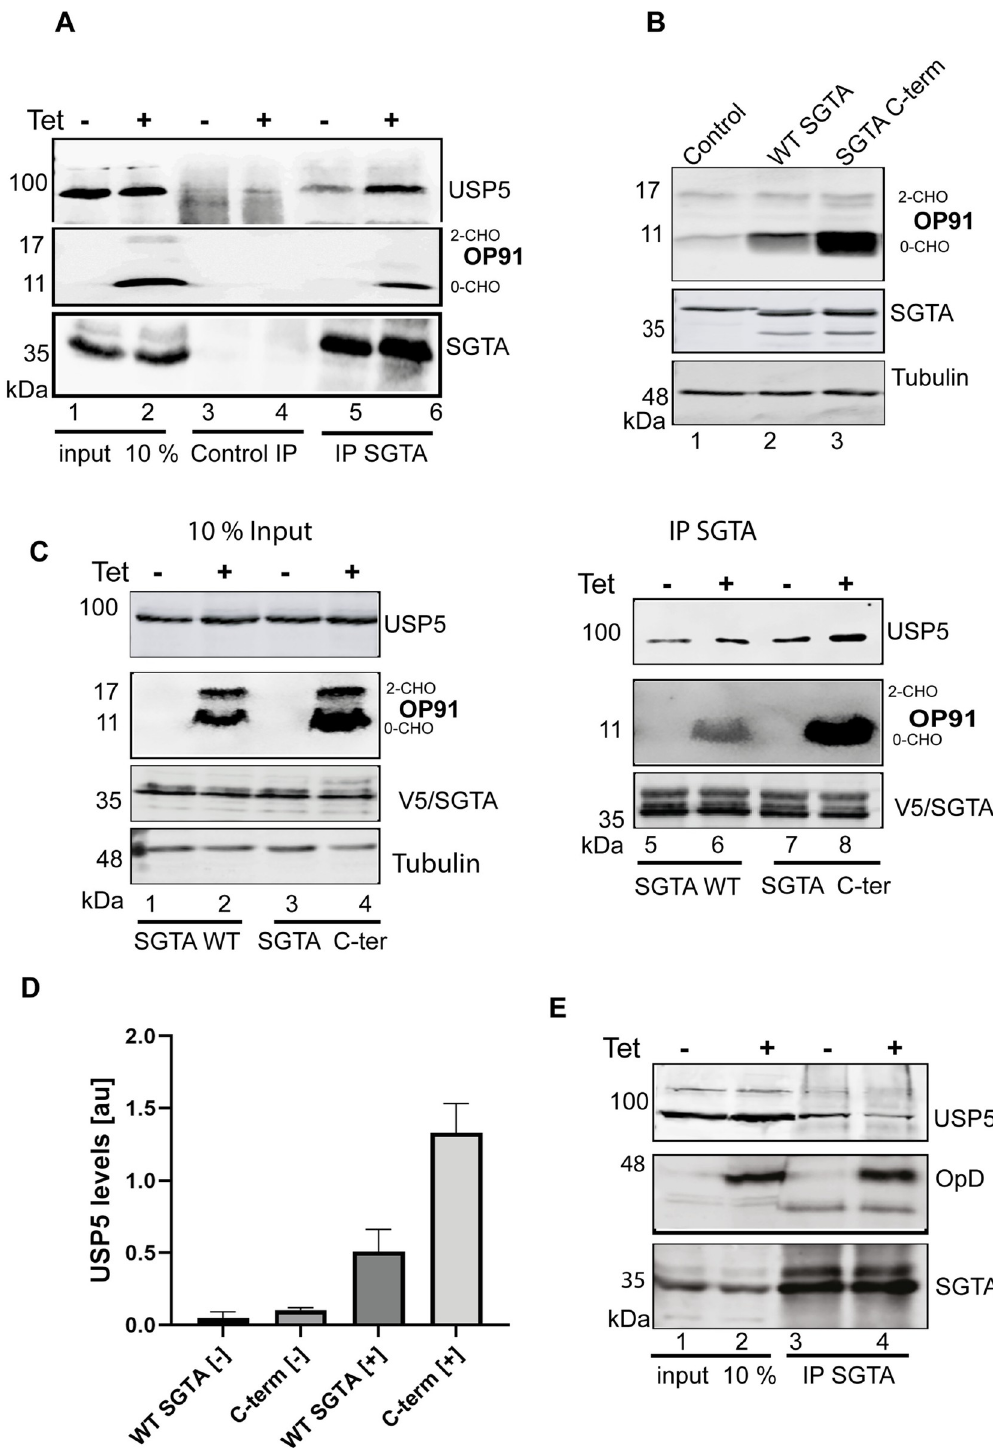
Fig 7. Association of SGTA and USP5 is enhanced in the presence of an MLP. A) HeLa T-REx Flp-In cells stably expressing OP91 after induction were seeded at 50% confluence and induced to express OP91 in half of the samples. After growth, cells were harvested into non-denaturing buffer and subjected to co-immunoprecipitation using SGTA antibodies or IgG antibodies as negative control. Products were analysed by western blotting using antibodies against opsin (OP91), V5 (SGTA) and tubulin (loading control). B) HeLa TRex Flp-In cells stably expressing OP91 after induction were